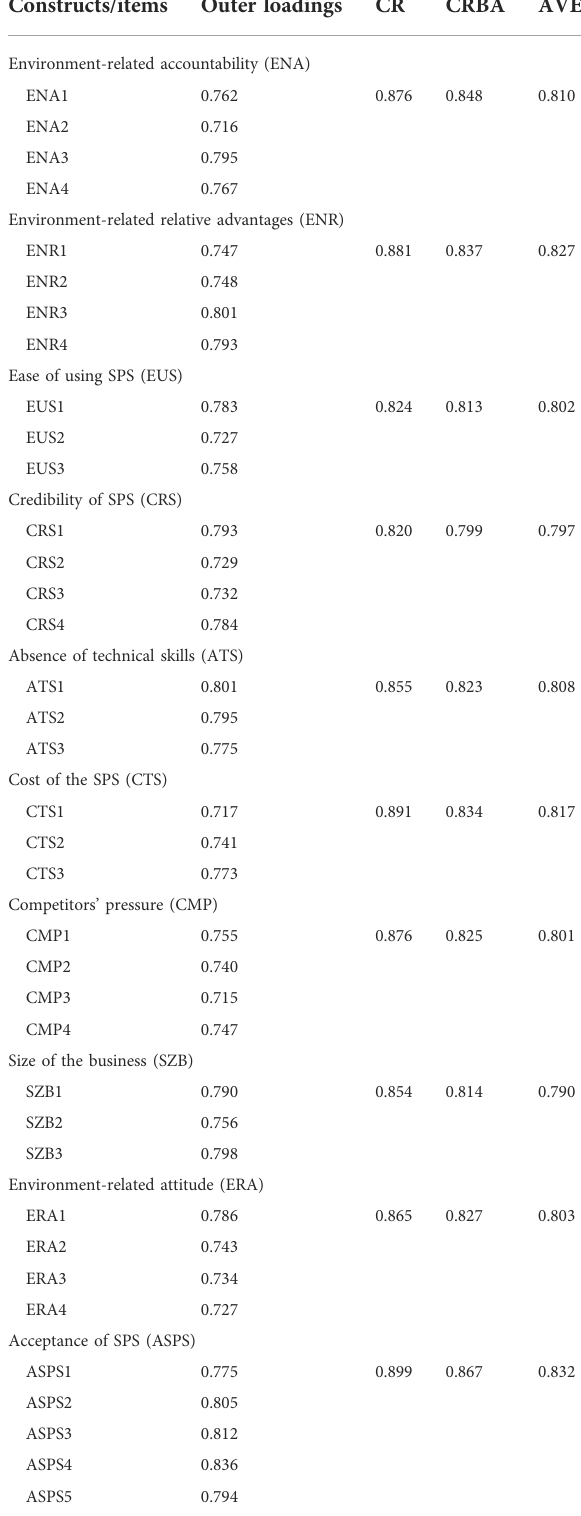
TABLE 1 Results of measurement